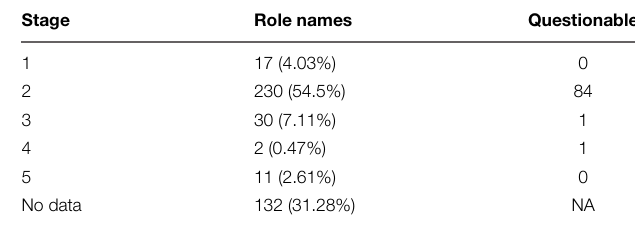
TABLE 1 | List of data collection